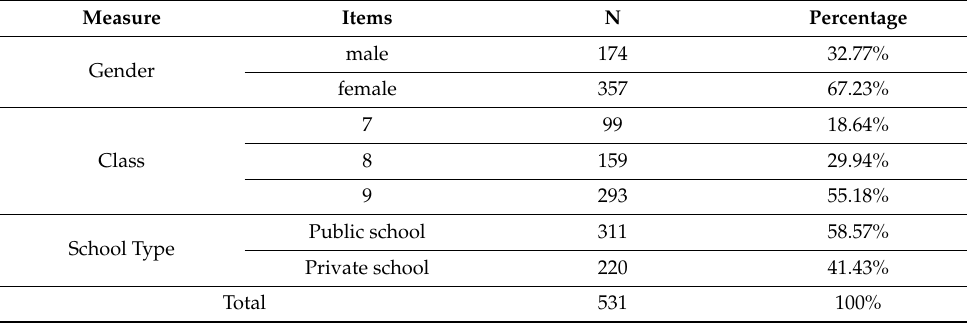
Table 1. Descriptive statistics of students in this